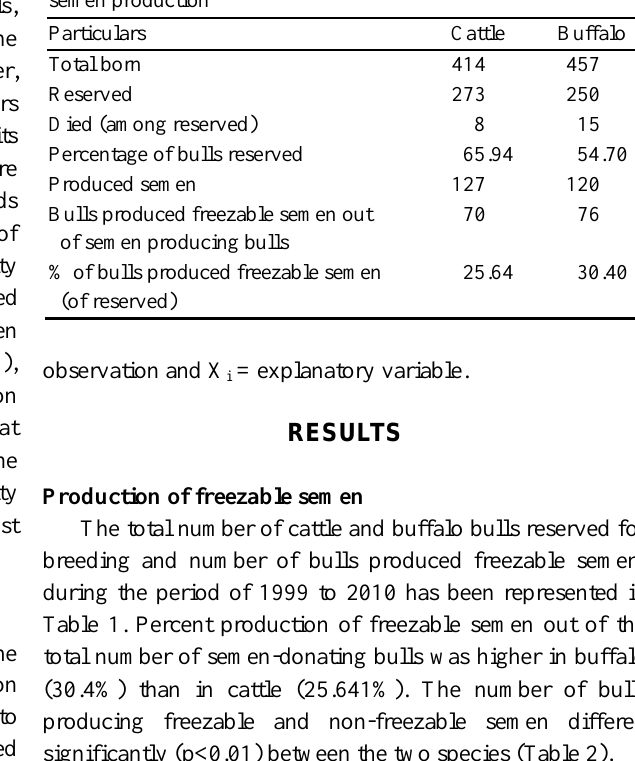
Table 1. Detail of male calves born and reserved for freezable